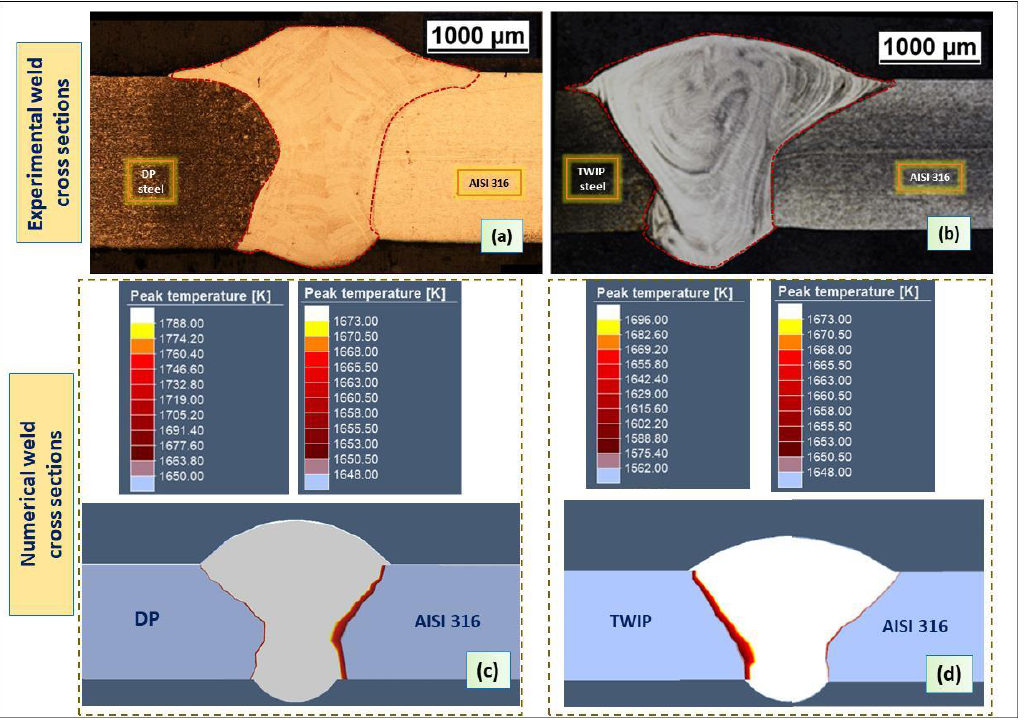
Figure 7. ( a , b ) Actual transversal sections; ( c , d ) numerical transversal sections.